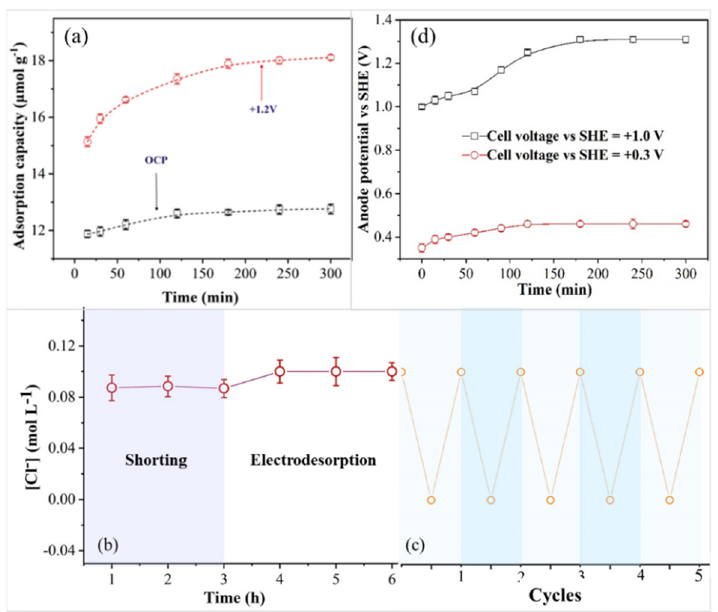
Figure 2. Electrosorption and desorption cycles. ( a ) Comparison of Cl − adsorption capacity at OCP and 1.2 V. ( b ) The concentration of Cl − with and without cathodic polarization ( c ) cycles for adsorption and electrodesorption. ( d ) The curve of anode potential changed with cell voltage in the electrosoption process.